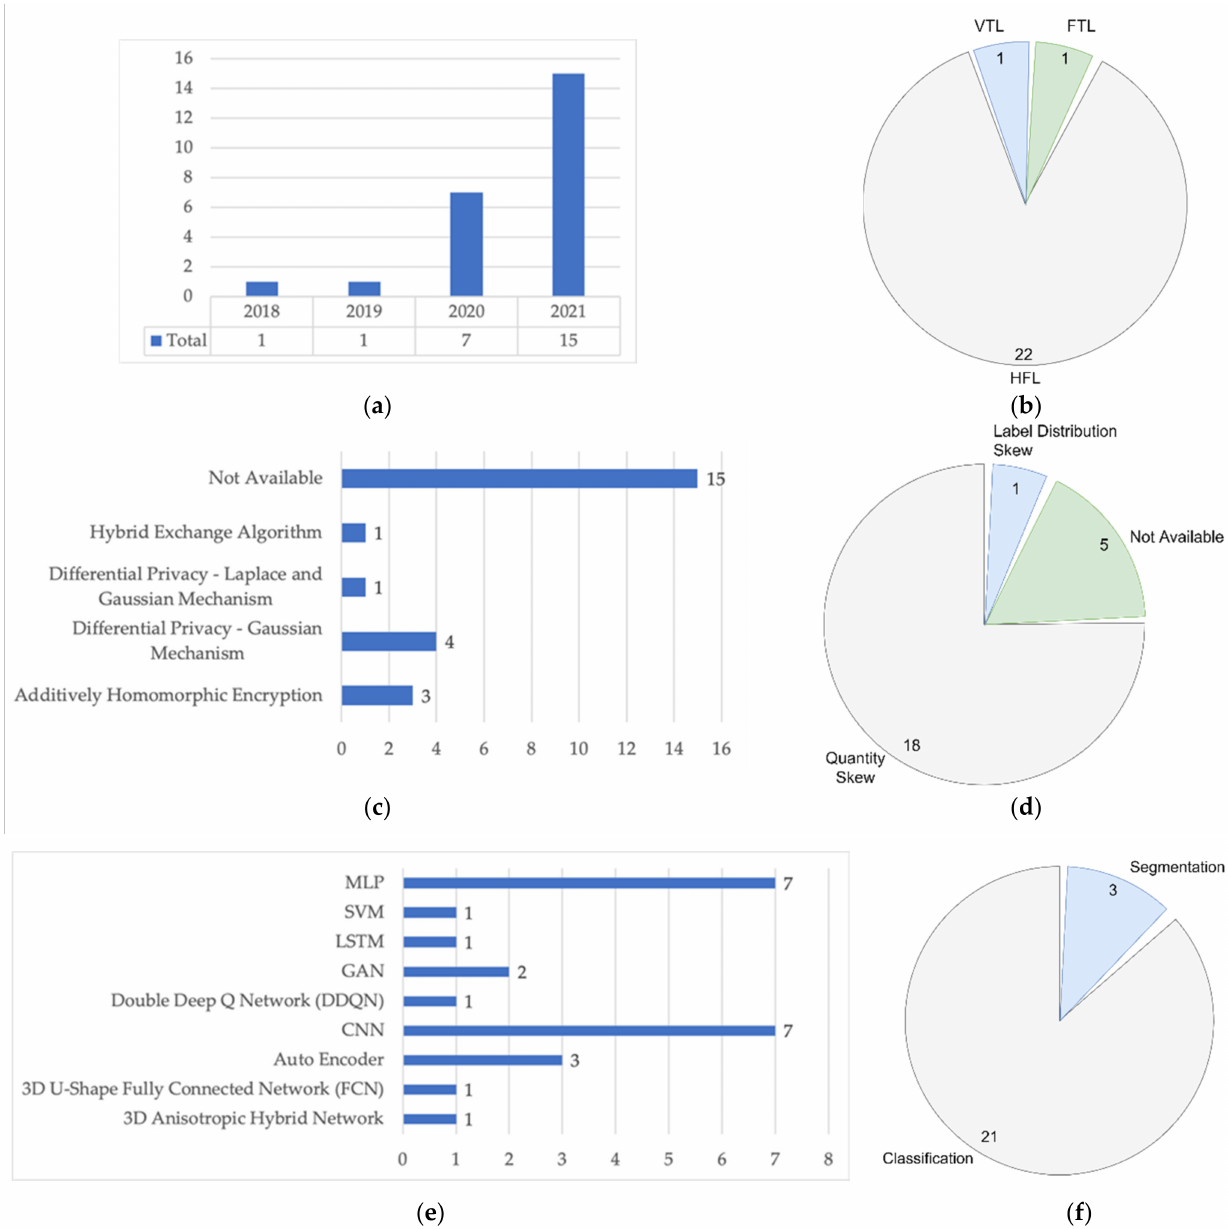
Figure 4. Numerical description of published articles in federated learning for medical applications. ( a ) The number of FL studies published in medical application included in the review, 2018–2021; ( b ) number of data partition characteristics employed in FL; ( c ) various data privacy algorithms employed in federated learning for the healthcare area; ( d ) number of non-IID characteristics discussed in FL studies published in the medical domain; ( e ) various machine learning models employed in federated learning for the healthcare area; ( f ) number of FL studies published in medical application included in the systematic